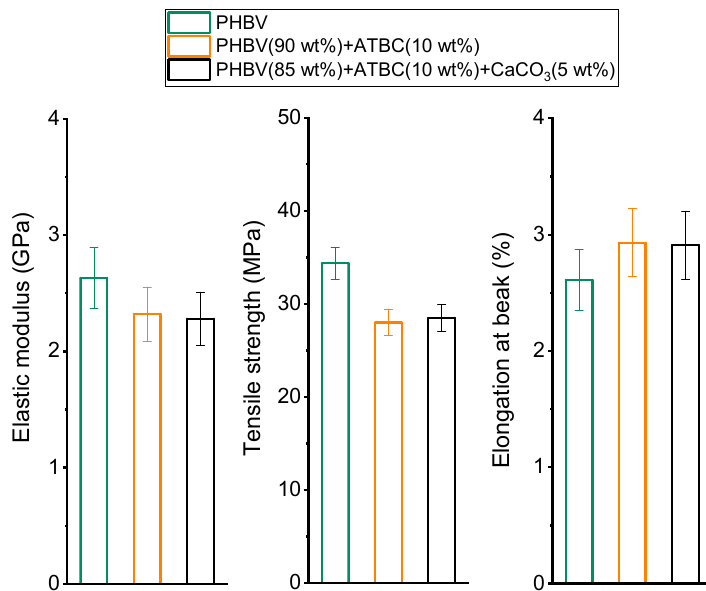
Figure 4. Elastic modulus, tensile strength and elongation at break of PHBV and PHBV mixed with ( i ) ATBC and ( ii ) ATBC and the mineral filler CaCO 3 at the concentrations indicated (estimated errors from standard deviation for elastic modulus, and elongation at break: ± 10%; for tensile strength ± 5%).